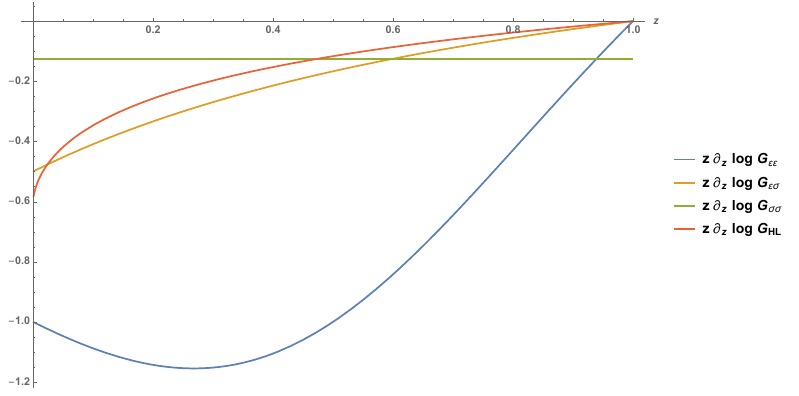
Figure 46 . Plots of z@ z log G that are all negative for our examples. We used h L = 2 and (cid:11) = 0 : 7. This sign is determined by the sign of the derivative of the logarithm of G ( z; (cid:22) z ) which